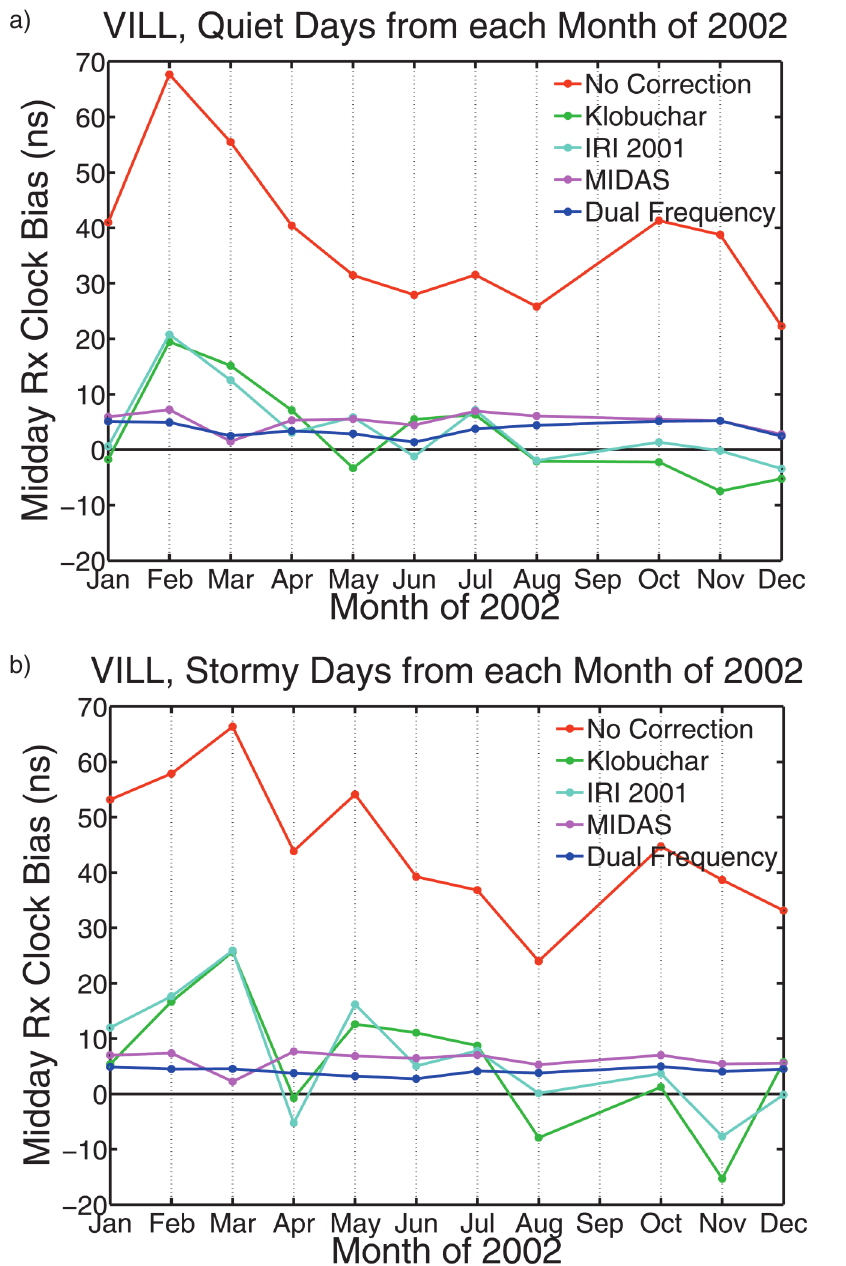
Fig. 6a,b. Midday (12:00 UT) receiver clock bias referenced to the receiver clock bias from CODE (using the fixed receiver solution) for one quiet day (a) and one stormy day (b) from each month of 2002 at VILL, exclud- ing September due to data